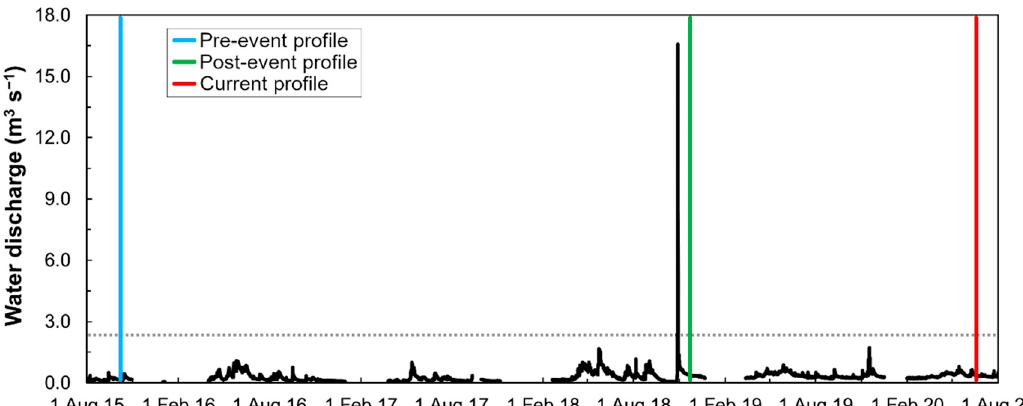
Figure 2. Water discharge experienced by the Rio Cordon during the study period. Until the Vaia storm, the water discharge was measured by the Rio Cordon monitoring station. From Vaia onward, due to the interruption in the monitoring station operations caused by the event, the water discharge acting in the Rio Cordon was determined starting from the Fiorentina Stream discharge and using a specific basin to sub-basin discharge extrapolation. The vertical blue, green and red lines identify the longitudinal profile surveys realized during the pre-event, post-event and the current conditions. The horizontal gray dashed line shows the bankfull discharge (2.30 m 3 s − 1 ).